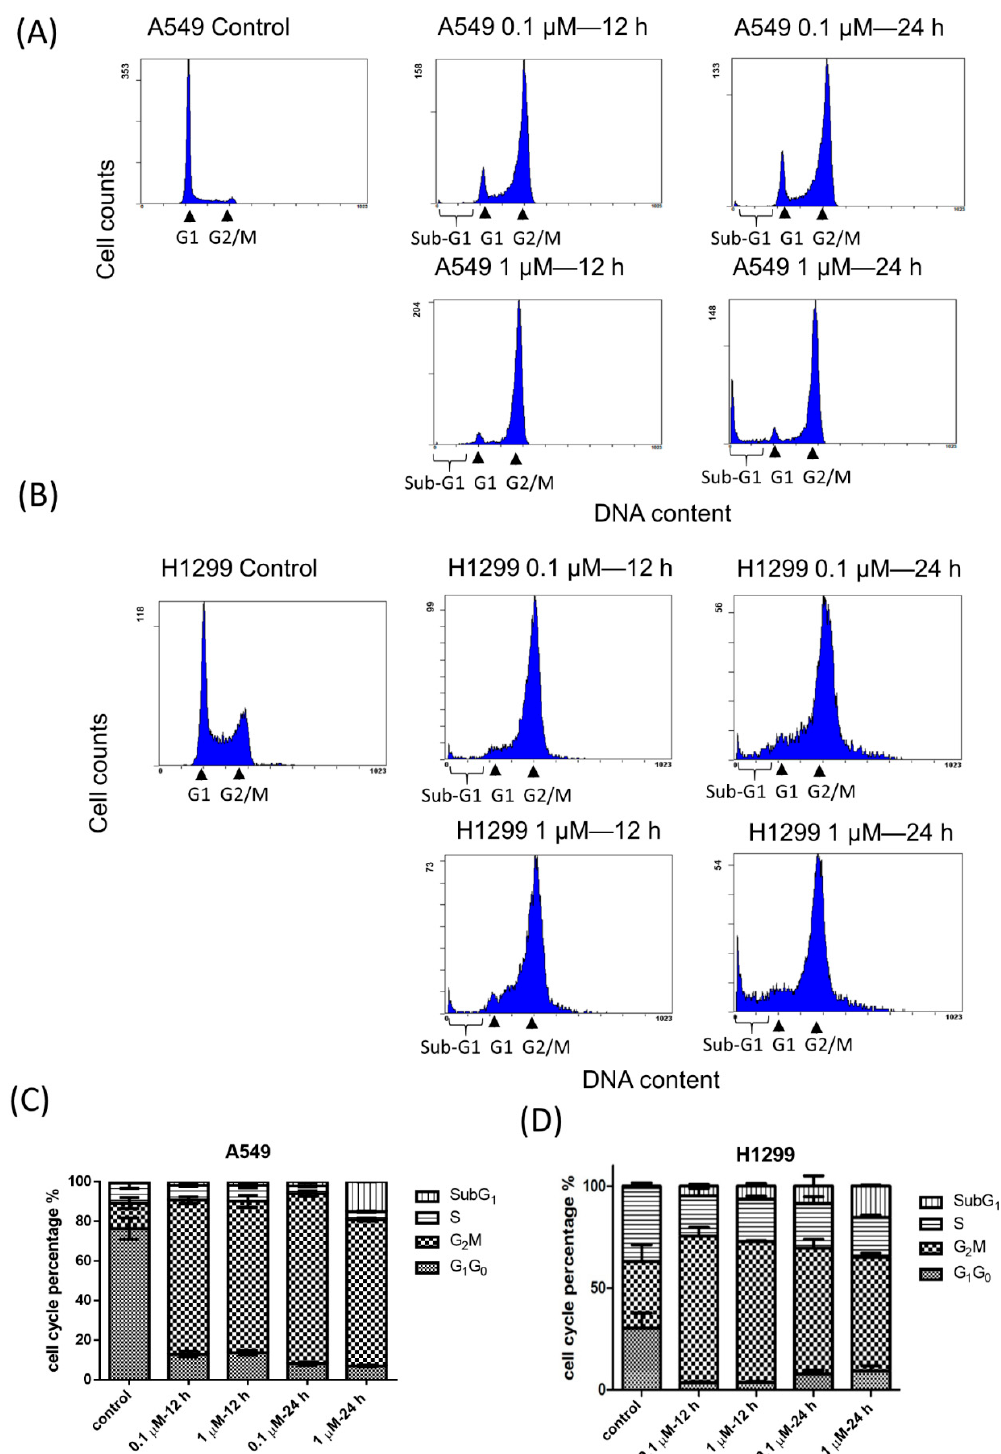
Figure 3. Comparison of sub ‐ G1 phase of NSCLC cells treated with high and low concentration of BPR0C261. The sub ‐ G1 phase of ( A ) A549 cells and ( B ) H1299 cells treated with 0.1 M and 1 M of BPR0C261 for 12 h and 24 h. ( C , D ) Quantification of percentage of sub ‐ G1 phase in A549 cells and H1299 cells treated with BPR0C261, respectively. Each datum represents the mean of three independent experiments ± S.D.